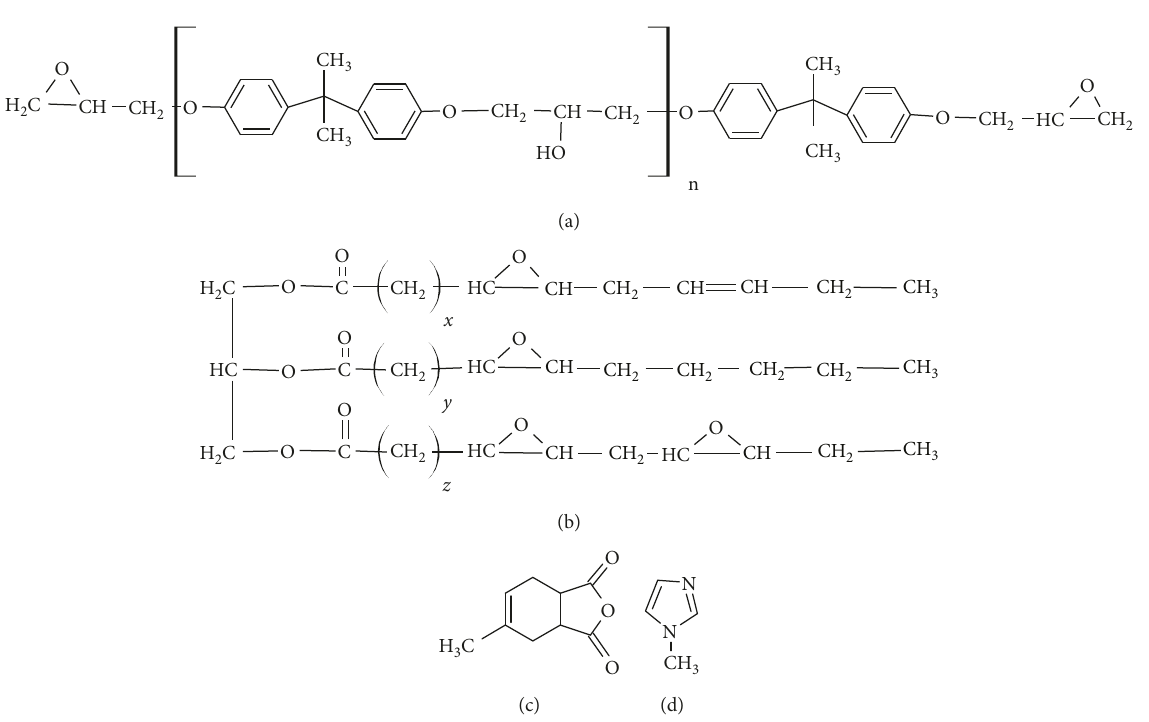
Figure 1: Representative chemical structures of (a) DGEBA ( n = 0 109 ) and (b) ESO and chemical structures of (c) MTHPA and (d)